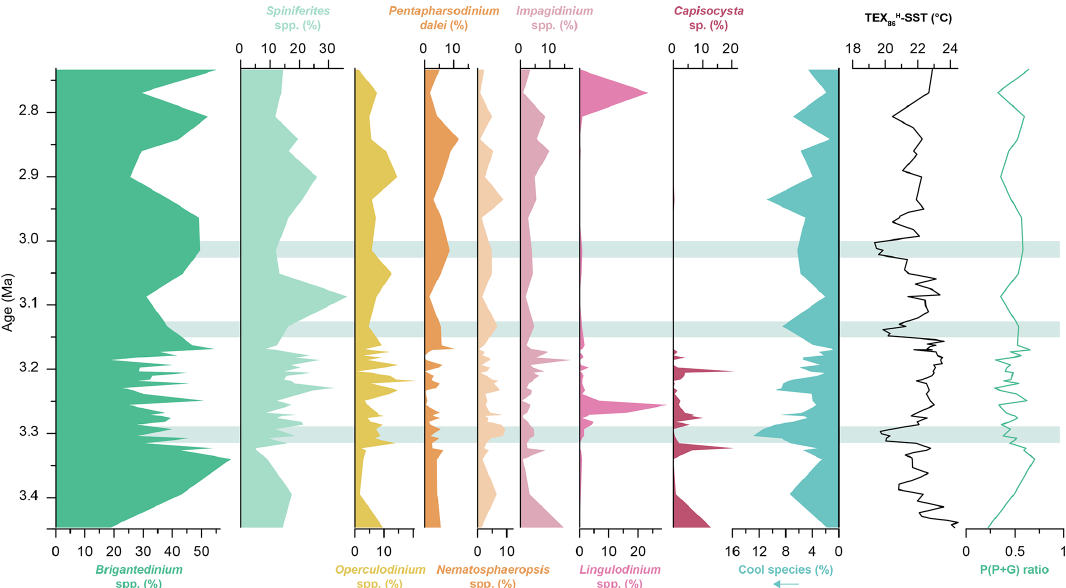
Figure 4. Relative abundances of the major groups of dinoflagellate cysts, the sum of dinocysts with cold affinities (“Cool species”) and P/ ( P + G ) paleoproductivity index compared to TEX H and G20